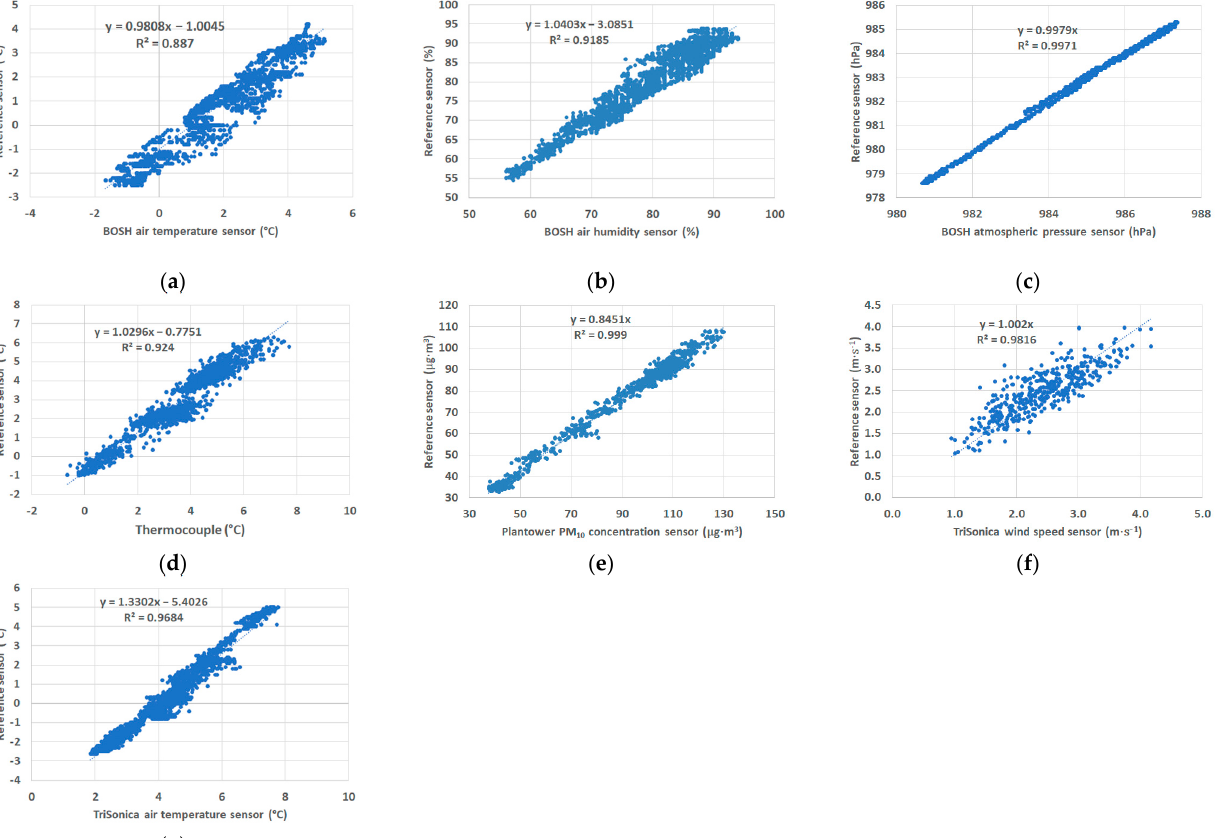
Figure 3. Comparison of the tested sensors with reference instruments: ( a ) air temperature—BOSH sensor; ( b ) air humidity—BOSH sensor; ( c ) atmospheric pressure—BOSH sensor; ( d ) air temperature—thermocouple; ( e ) PM 10 concentration— Plantower sensor; ( f ) TriSonica TM wind sensor, ( g ) TriSonica TM sonic temperature. Formulas of linear regression were used to correct the systematic error of measure- ments presented in this article.